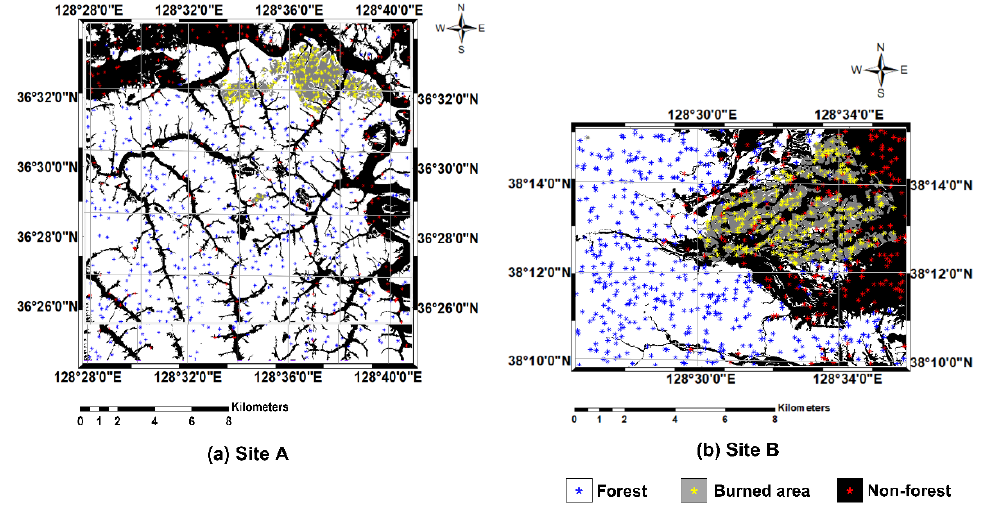
Figure 4. Visualization of sample points extraction for each class. ( a ) Sample points extraction of Site A, ( b ) Sample point extraction of Site B.